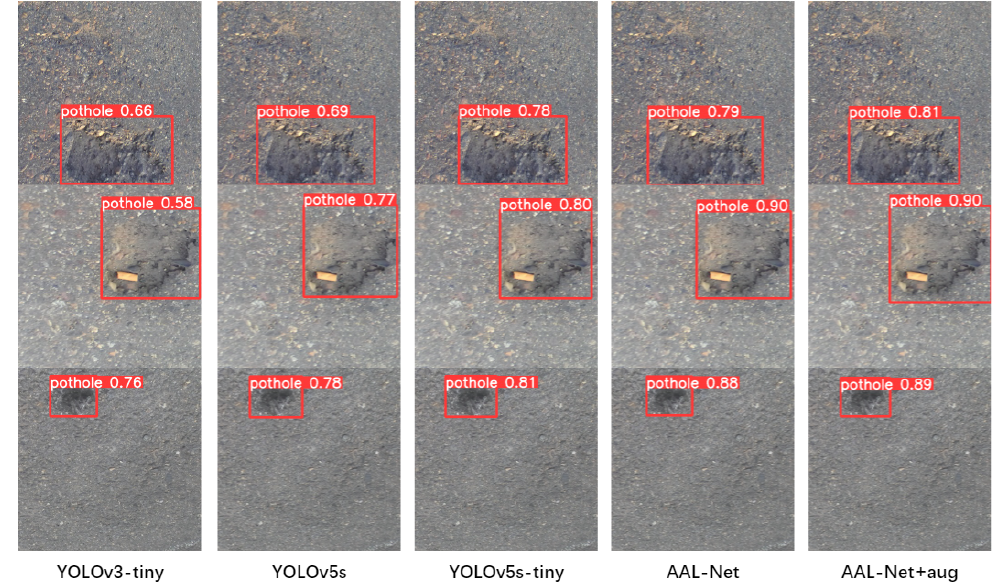
Figure 13. Visualization of image detection on the pothole600 dataset using different